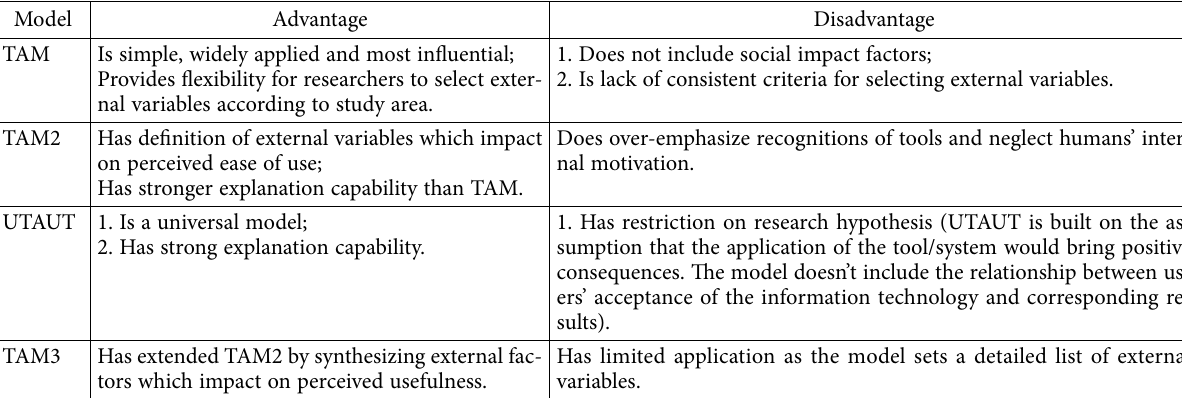
Table 1. Comparison of TAM